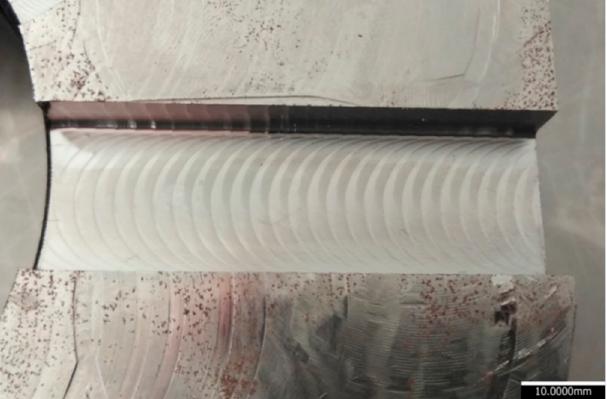
Figure 8. An example of a finished groove sample: the detail of one of the milled grooves with a noticeably higher surface waviness.